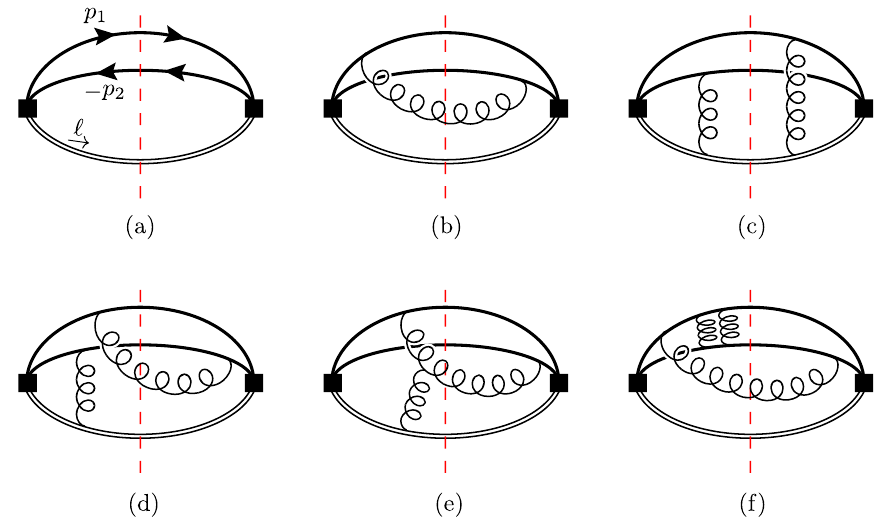
Figure 2 . Representative Feynman diagrams for the color-octet LDME h Ω |O Q ( p 1 ) ¯ Q ( p 2 ) ( 3 S [8] computed in perturbative QCD at (a) LO, (b) NLO, and (c)–(e) NNLO in α s . Solid lines are quark lines, double lines are the gauge-completion Wilson lines in the adjoint representation in the ‘ direc- tion, curly lines are gluons, dashed lines are final-state cuts, and filled squares represent operators which create a Q ¯ Q pair in a color-octet state. Diagram (f) shows a NNNLO contribution that contains a logarithmic IR divergence, which can be absorbed into the quarkonium